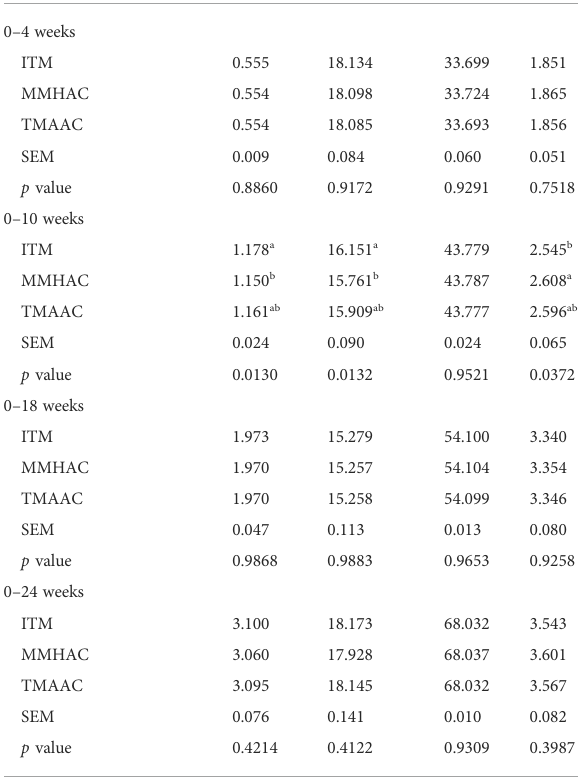
TABLE 5 Effect of inorganic or organic trace minerals on the performance of broiler breeders. Trace mineral